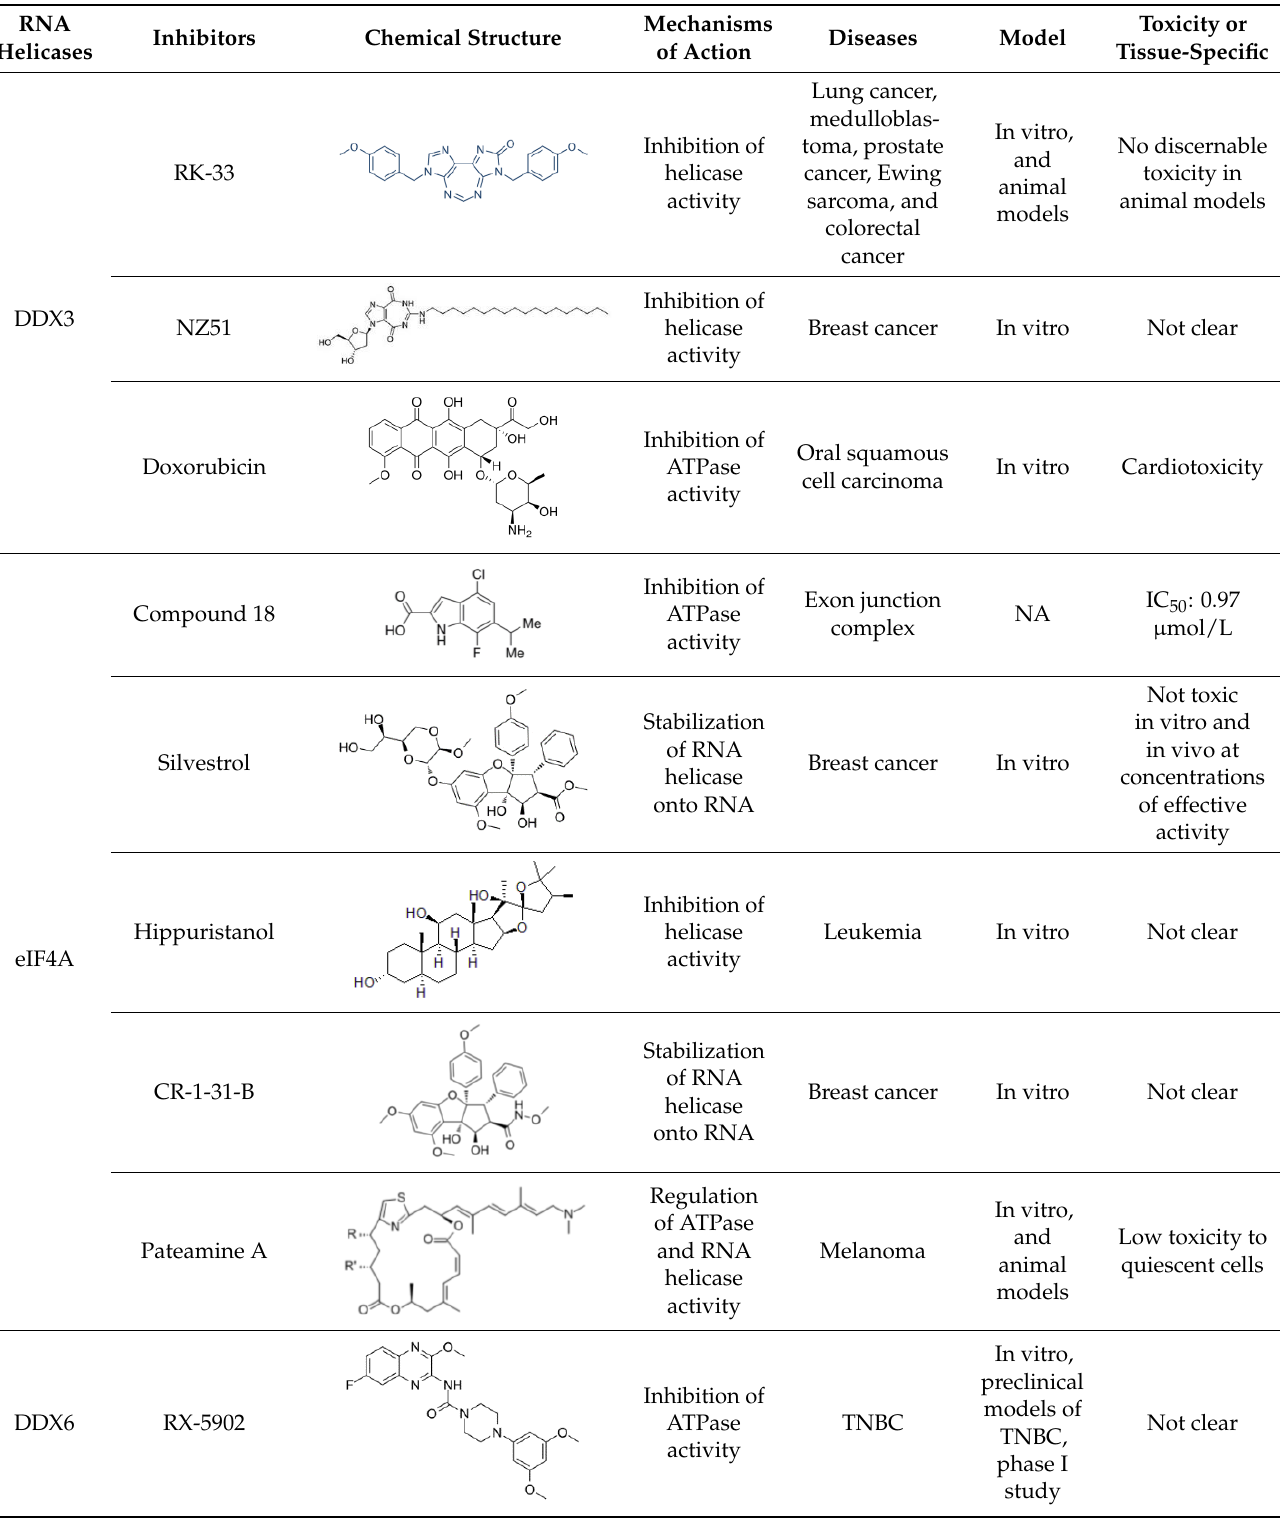
Table 2. The Structures and Sites of Action of RNA Helicase Inhibitors in Diseases.